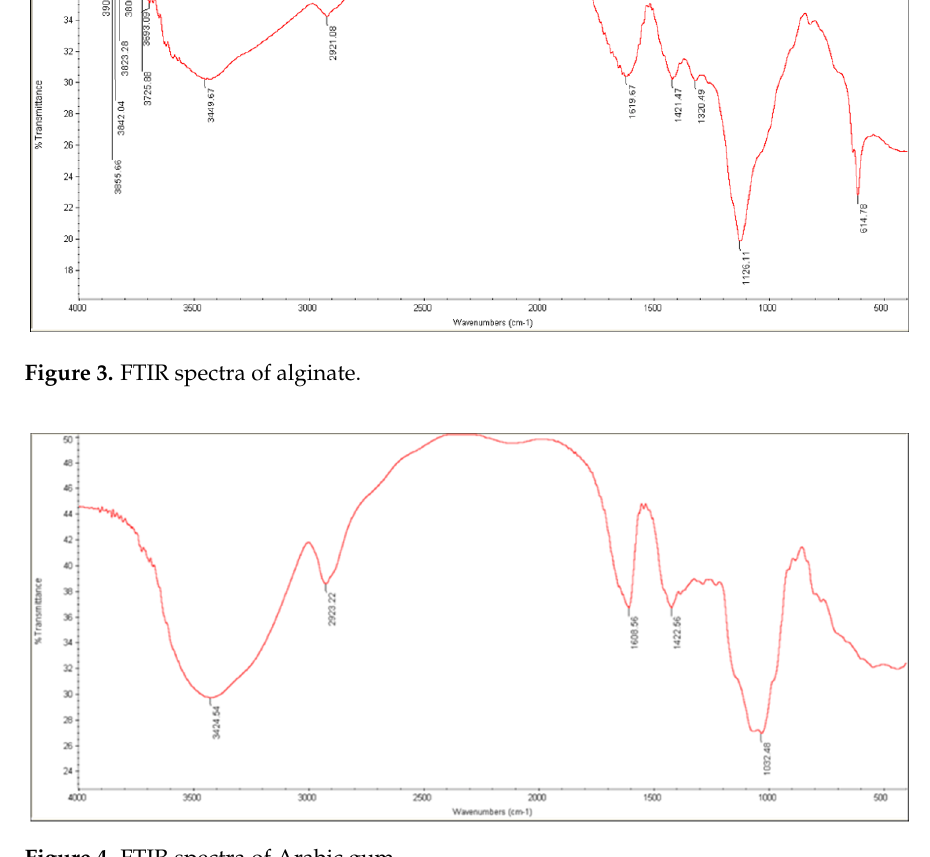
Figure 4. FTIR spectra of Arabic gum.